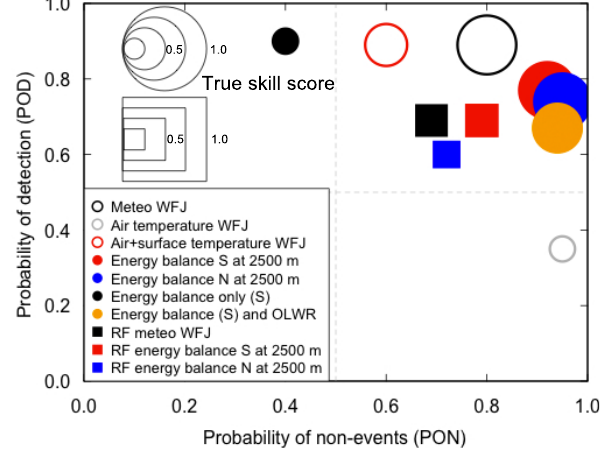
Fig. 6. Classification accuracy of different tree and RandomFor- est (RF) models for contrasting wet-snow avalanche days to non- avalanche days. Size of the symbols indicates the true skill